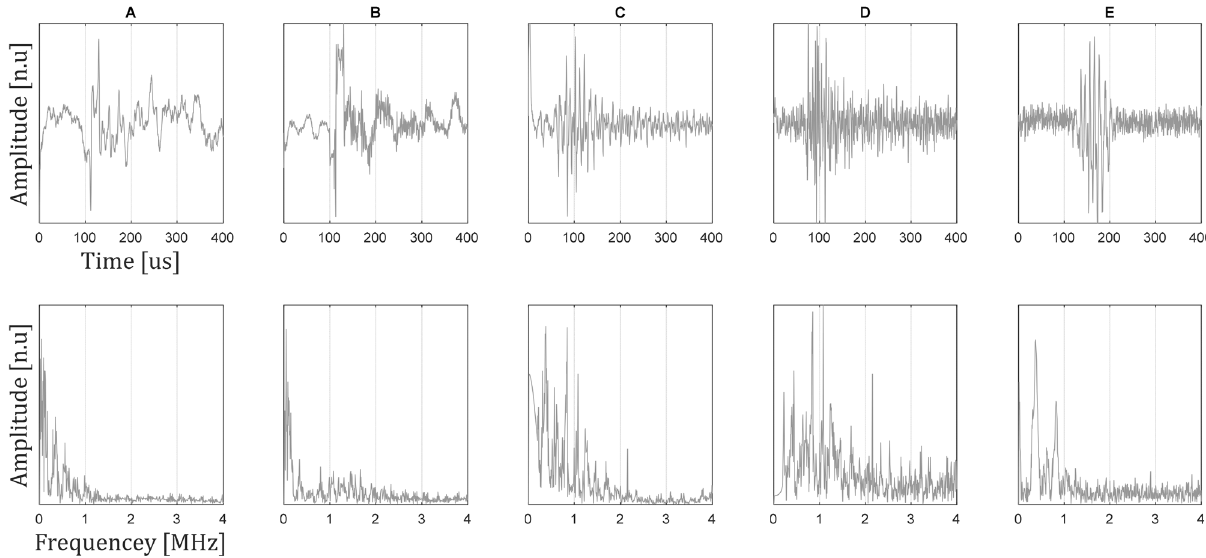
Figure 3. Signals recorded from each particle type separately. The signals were recorded using the piezo electric transducer, while in each of the recording a single type of particle was excited. The lower row is the spectrum of the signals,